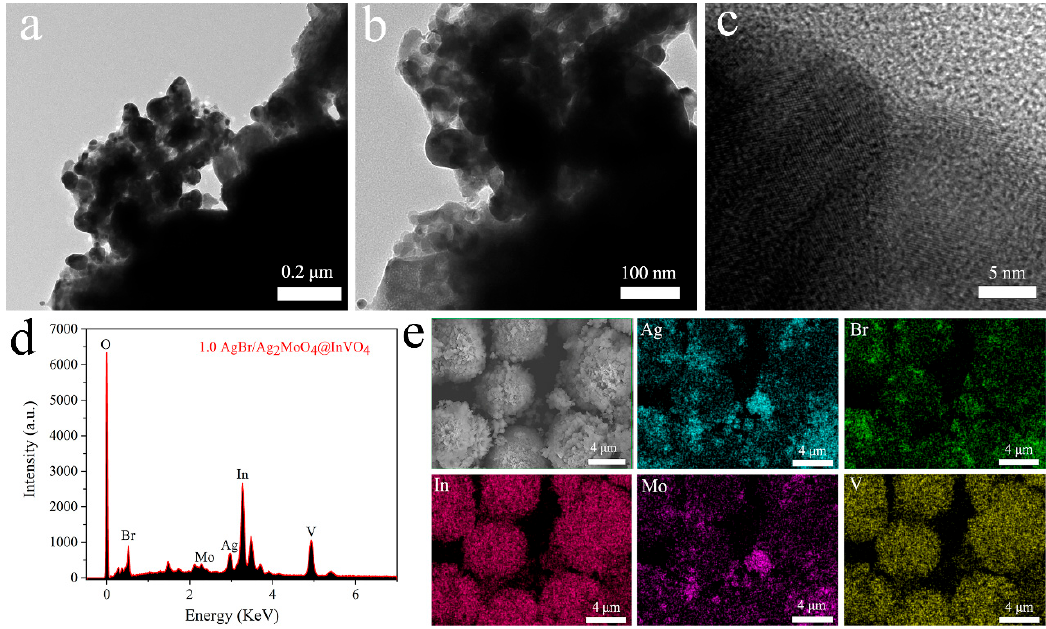
Figure 3. ( a – c ) TEM and HRTEM pictures of 1.0AgBr/Ag2MoO4@InVO4 of the photocatalysts. ( d ) EDS pattern and ( e ) EDX elemental pictures of as-prepared 1.0AgBr/Ag 2 MoO 4 @InVO 4 photocatalysts.